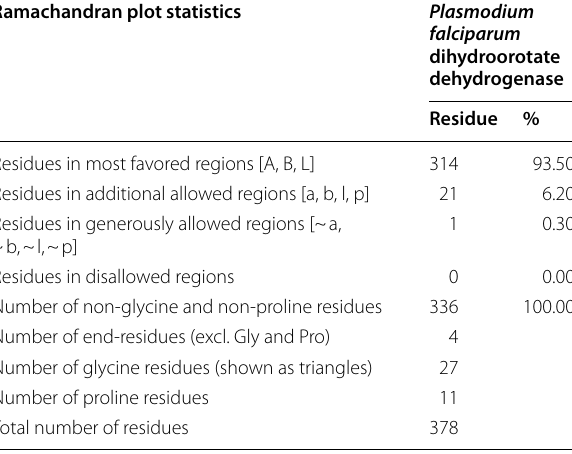
Table 2 Ramachandran plot of